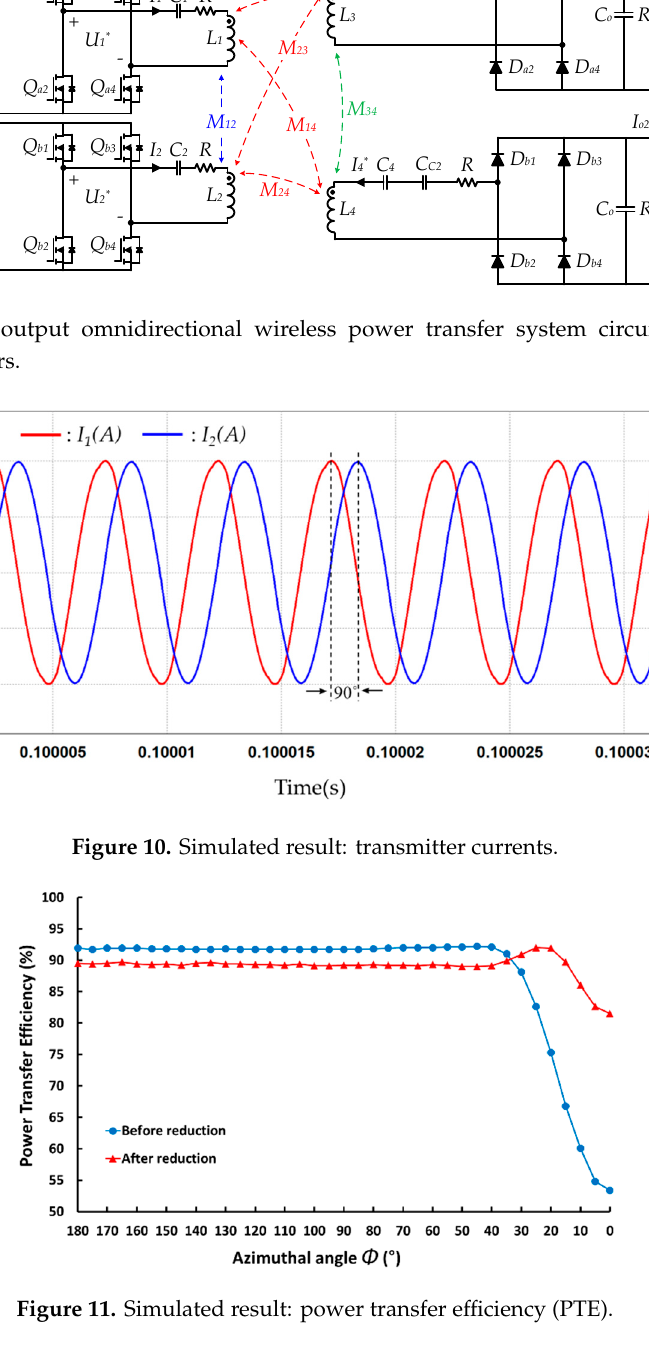
Figure 11. Simulated result: power transfer efficiency (PTE).